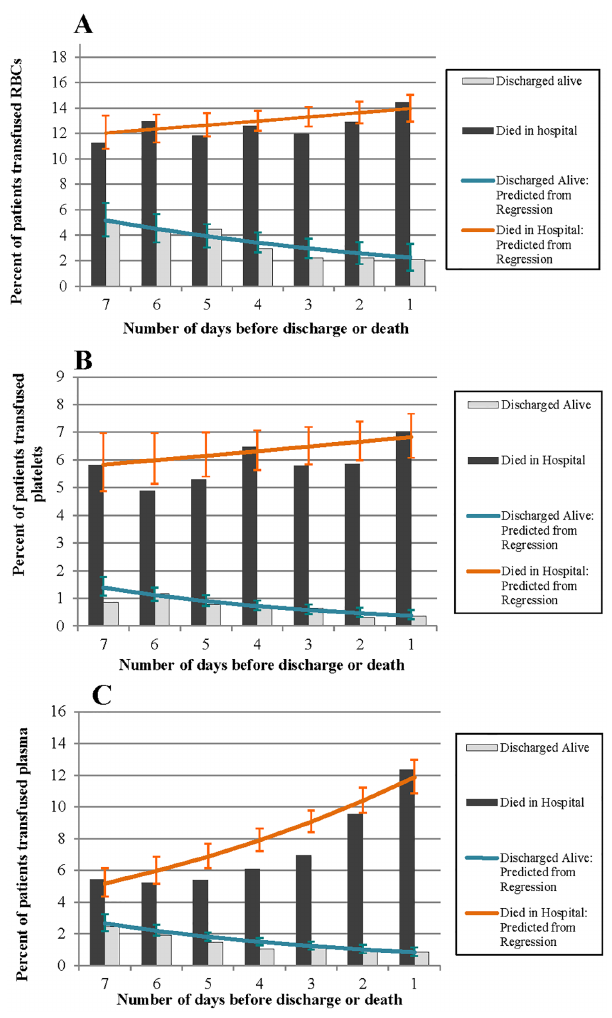
Fig 2. Observed and predicted percentage of patients in the ICU who were transfused A) RBCs, B) platelets and C) plasma on each of the 7 days leading up to discharge (alive) or death.